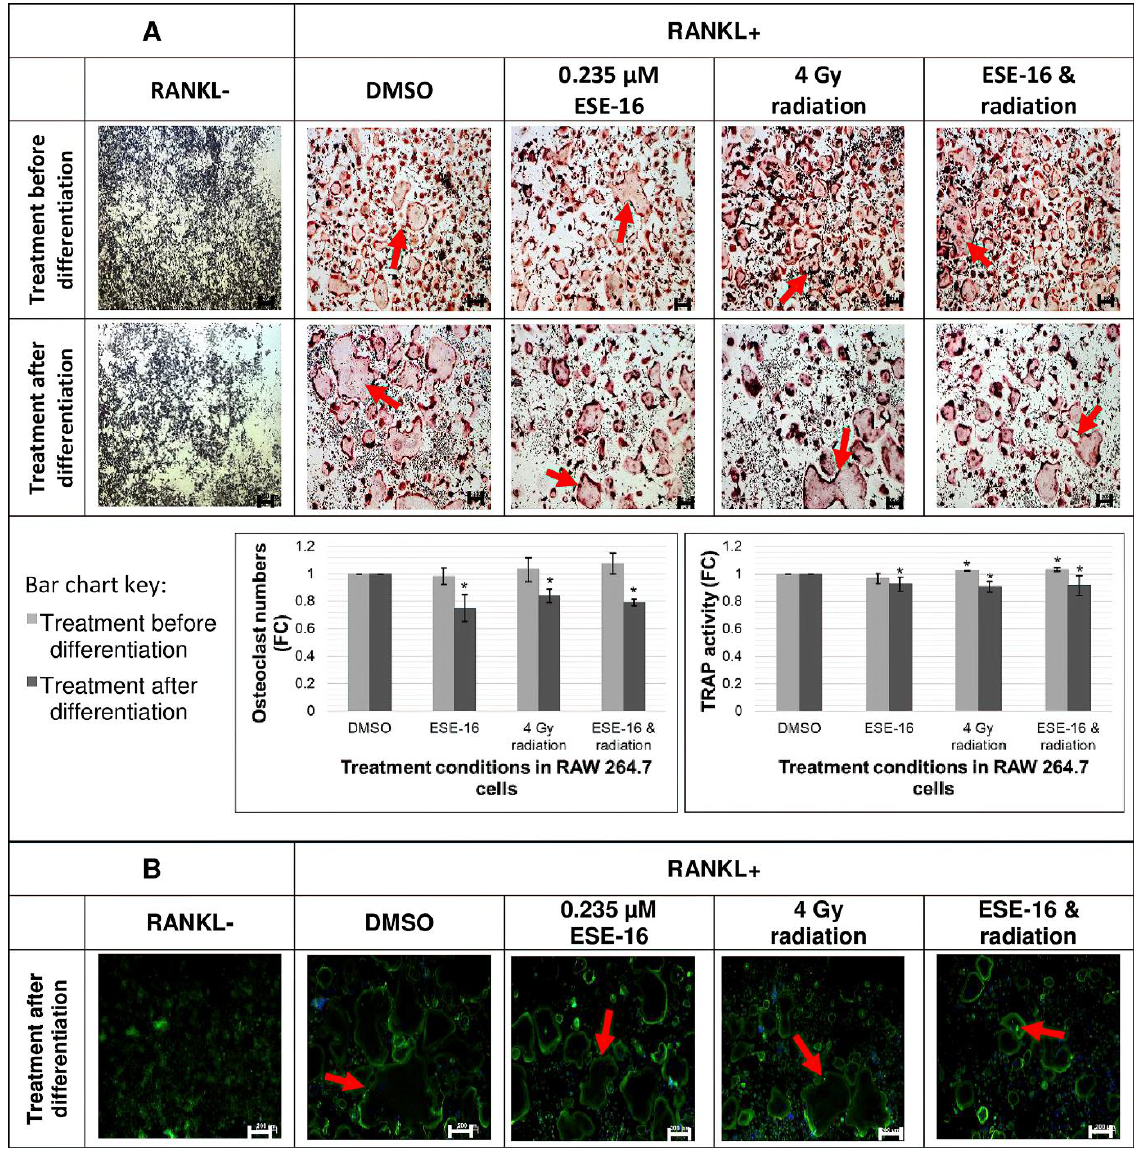
Figure 7. Osteoclast differentiation and activity in RAW 264.7 macrophages exposed to ESE-16 and 4 Gy radiation. ( A ) TRAP activity and staining in RAW 264.7 macrophages treated either before or after differentiation (5X magnification, 200 µm scale bar), with multinucleated osteoclasts indicated by arrows. The effects of ESE-16 and radiation on osteoclast differentiation were more notable in RAW 264.7 macrophages treated after differentiation. ( B ) Actin ring formation in RAW 264.7 macrophages treated after differentiation (5X magnification, 200 µm scale bar). Treated mature osteoclasts showed fewer osteoclasts with intact actin ring structures (indicated by arrows). Bar charts represent the means of three biological repeats with SD indicated by T-bars. Statistical significance ( p -value < 0.05) indicated by * when compared to DMSO.